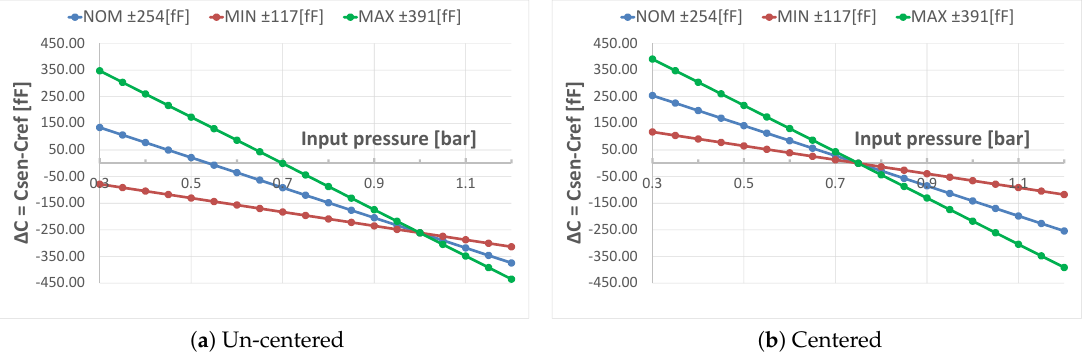
Figure 7. Single-ended un-centered ( a ) and centered ( b ) linearized equivalent pressure sensor ∆ C reading over application input